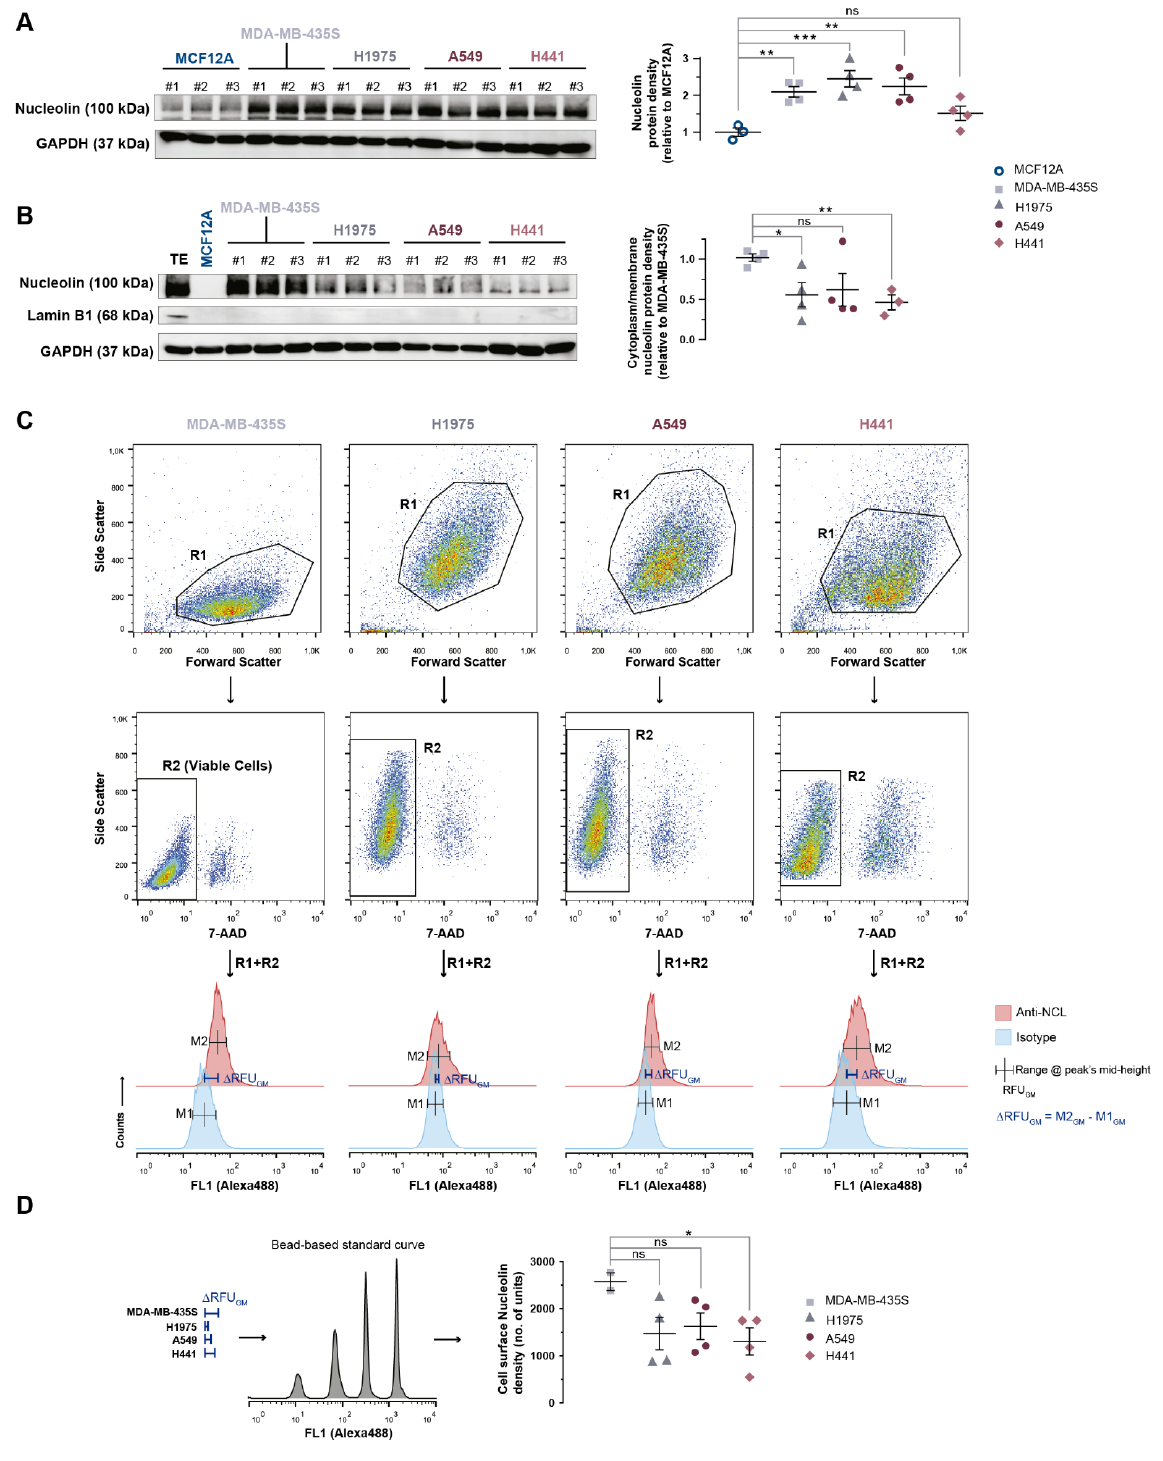
Figure 4. Density of nucleolin expression in lung cancer cell lines. Immunoblotting of nucleolin in total extracts ( A ) and in cytoplasm/membrane fractions ( B ) of non-small cell lung cancer H1975, A549, and H441, nucleolin-overexpressing MDA-MB-435S, and non-tumorigenic MCF12A cell lines. According to the condition, each lane represents an independent experiment. Data represent the